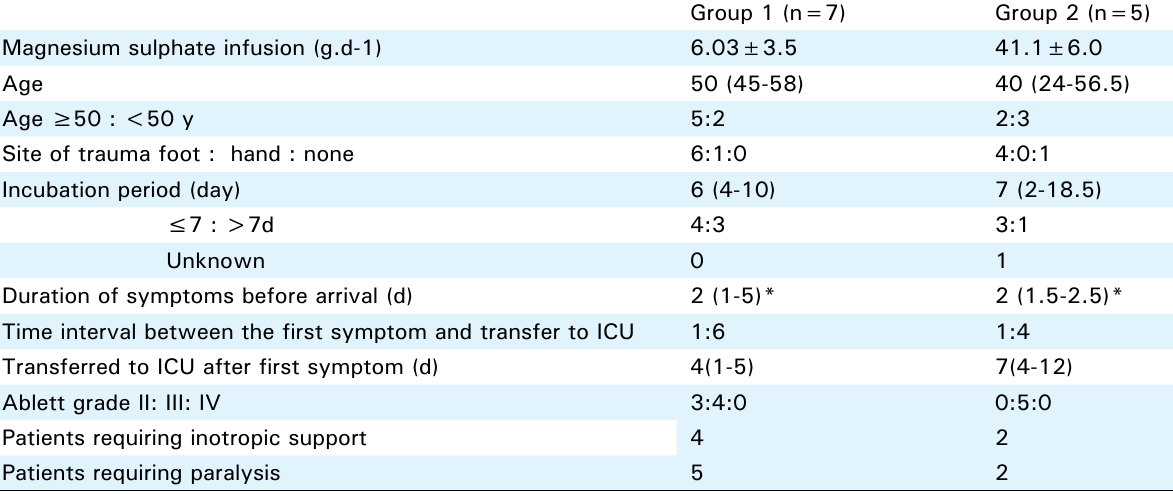
table 2. Summary of the characteristics of patients and disease. Values are expressed as mean ±SD, number or median (interquartile range) as